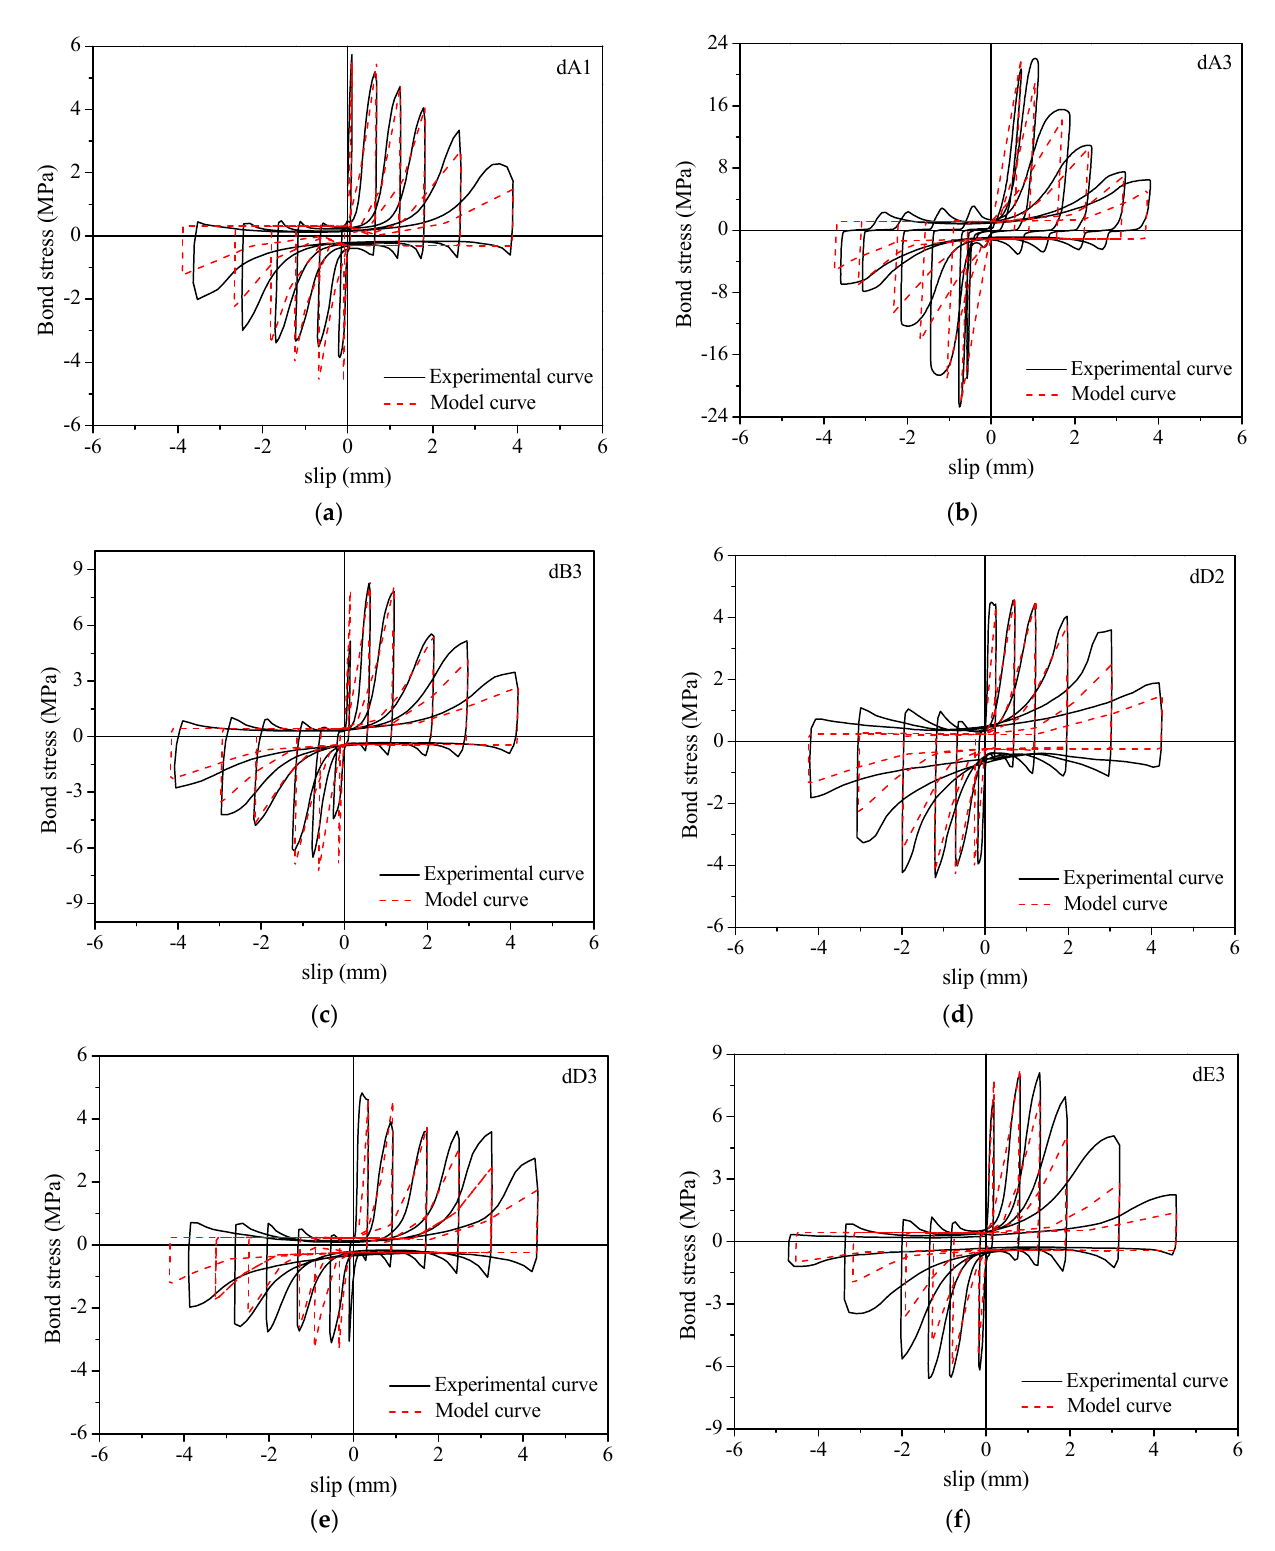
Figure 14. Comparison between the model curve and experimental curve under cyclic loading. ( a ) dA1; ( b ) dA3; ( c ) dB3; ( d ) dD2; ( e ) dD3; ( f ) dE3.